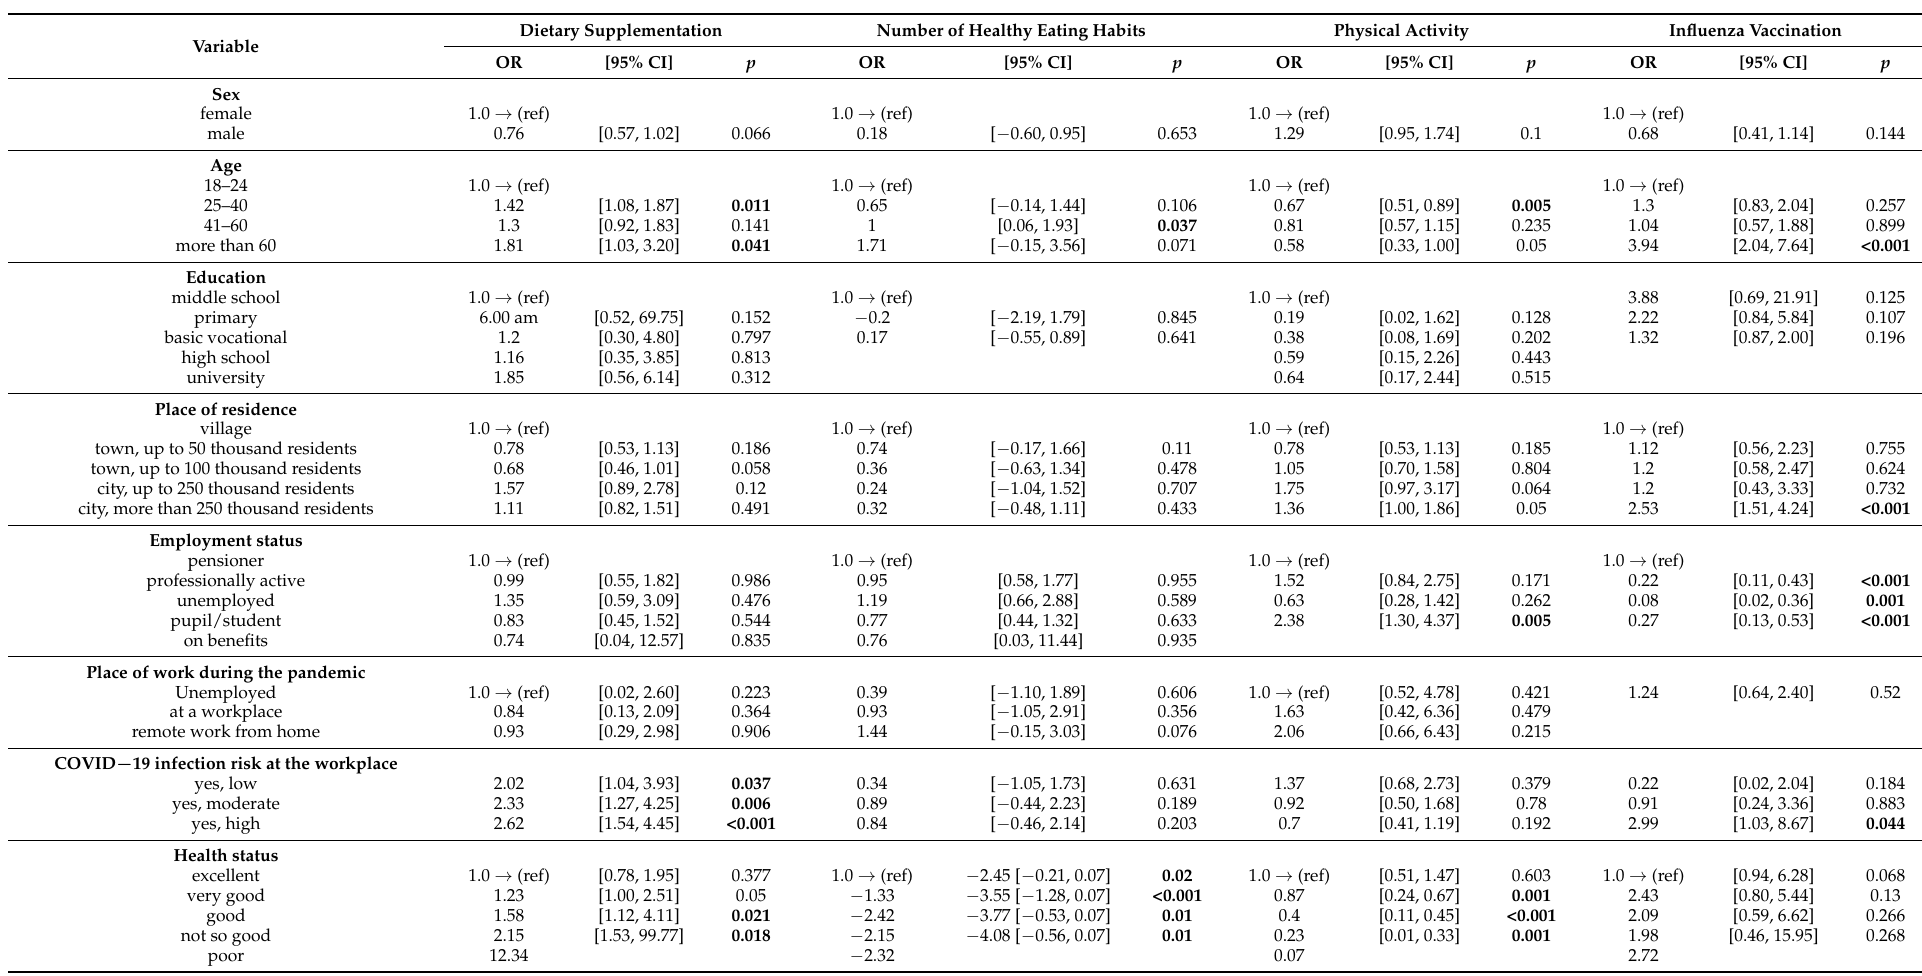
Table 4. Logistic regression analysis of selected factors associated with dietary supplementation, adherence to healthy eating habits, physical activity and influenza vaccination among Poles during the “second wave” of the COVID-19 pandemic in Poland. Dietary Supplementation Number of Healthy Eating Habits Physical Activity Influenza Variable